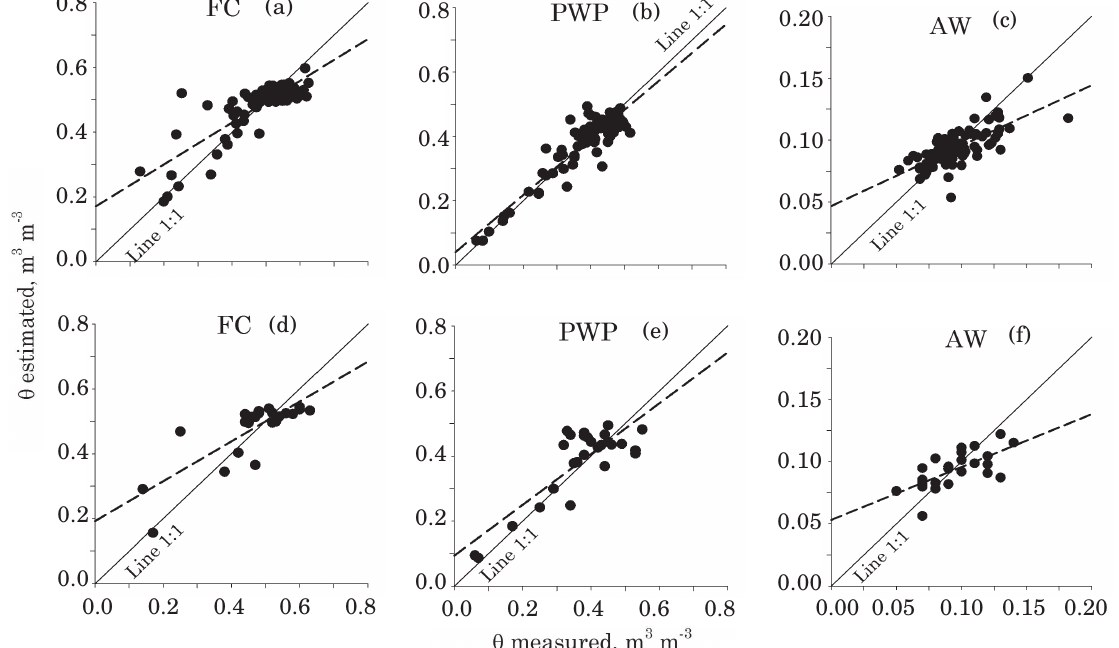
Figure 10. Field capacity (FC), permanent wilting point (PWP) and available water content (AW) measured and estimated by PTFs of the full model: five sand classes, silt, clay, organic matter, bulk density, particle density, total porosity and their interactions for the generation database (a, b, c) and validation database (d, e, f) for subsurface horizons of soils of the State of